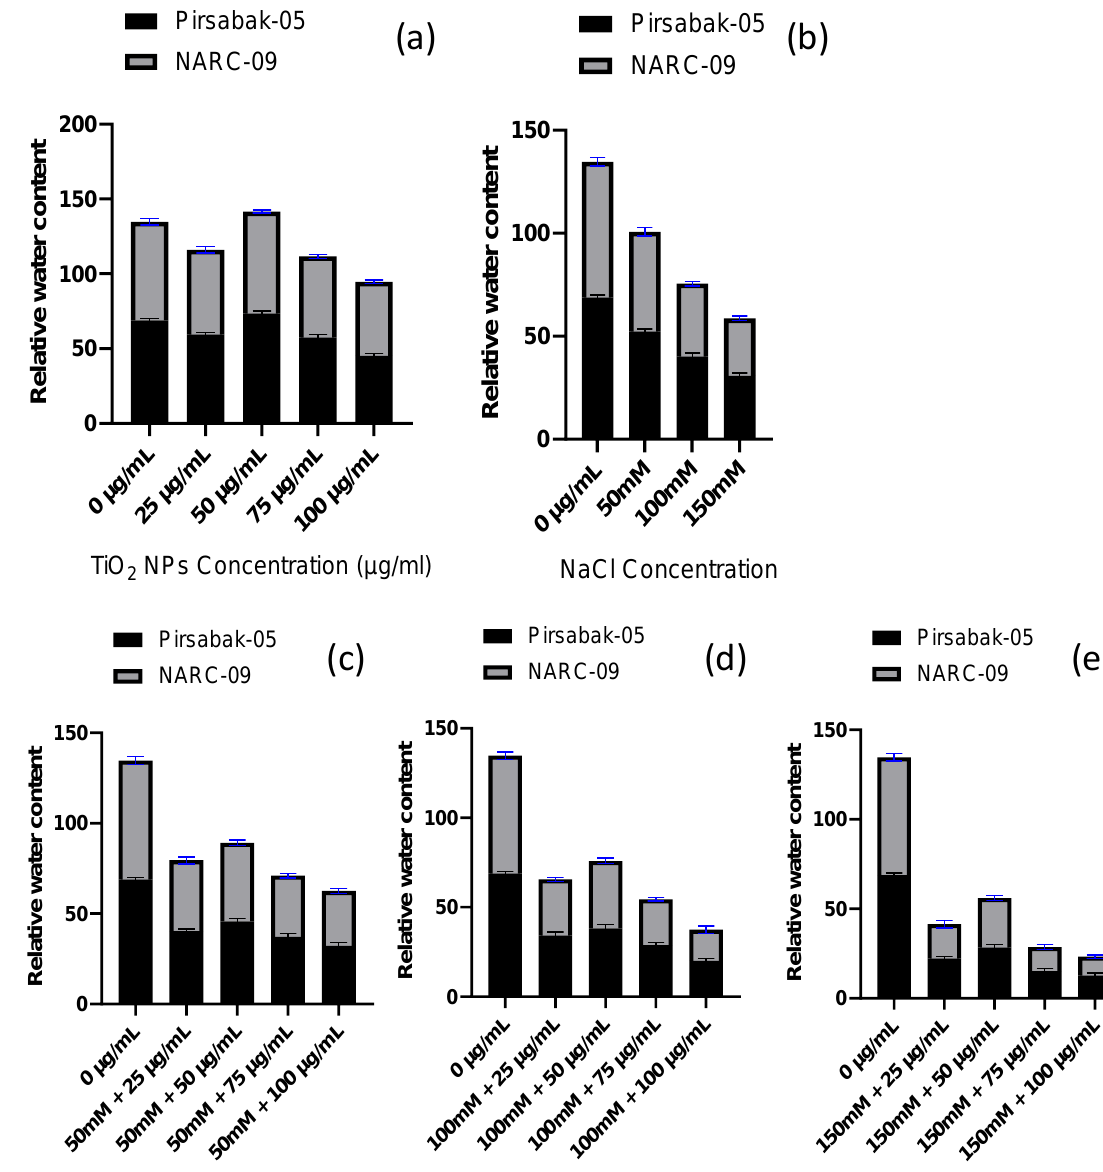
Figure 3. Effects of biogenic TiO 2 NPs on the relative water content of selected wheat varieties under salinity stress conditions; ( a ) Effect of different concentrations of biogenic TiO 2 NPs on wheat varieties, ( b ) Effect of different concentrations of NaCl on wheat varieties, ( c – e ) Effect of different concentrations of TiO 2 NPs under varied concentrations (i.e., 50 mM, 100 mM, and 150 mM of NaCl). The data are represented in the form of means, while p was kept at p ≤ 0.05.